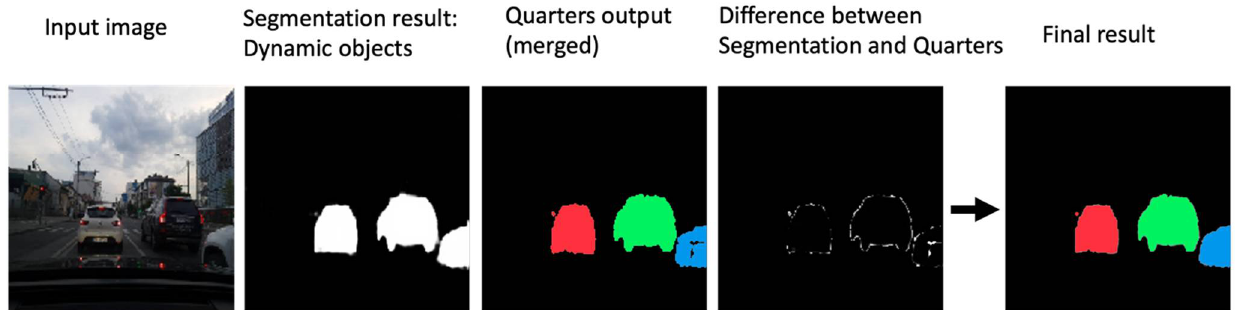
Figure 13. Fusing the semantic output with the quarters to improve object